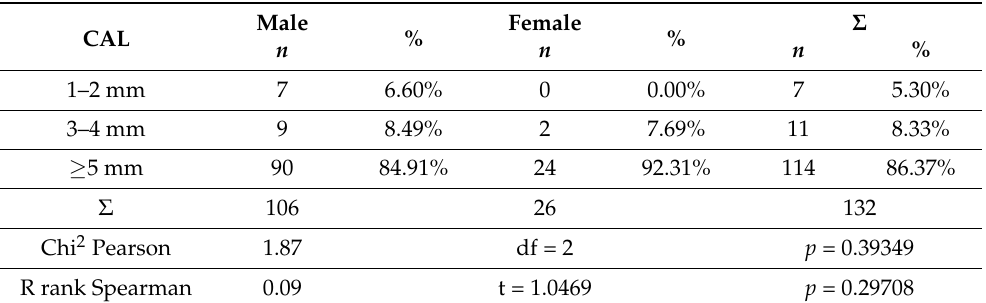
Table 3. Characteristics of the study population concerning connective tissue attachment loss (CAL) values at interproximal sites by gender.